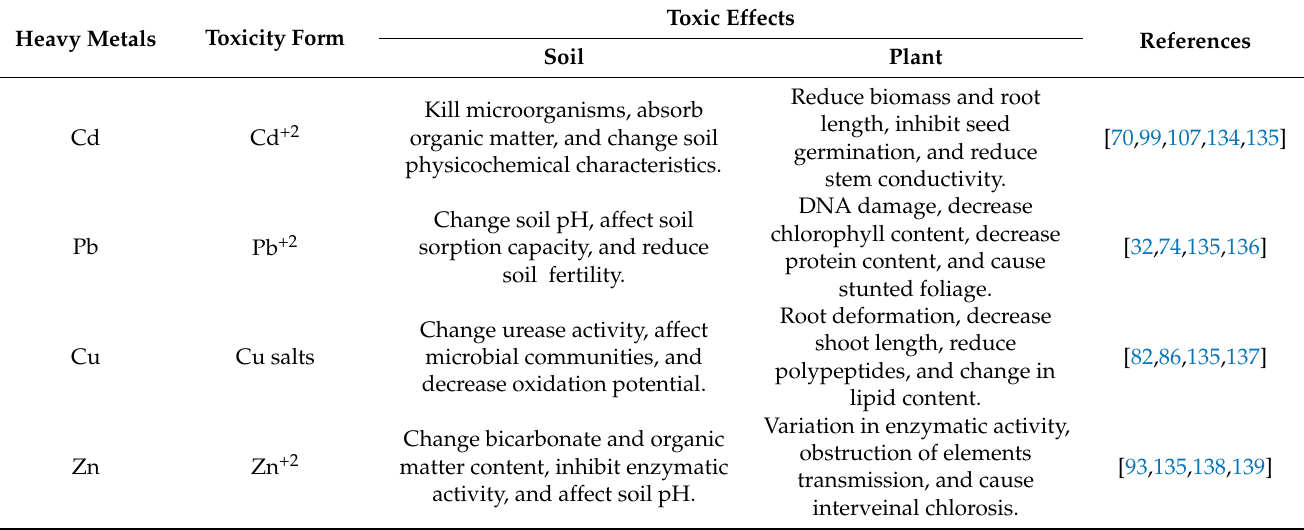
Table 5. Heavy metal toxicity forms and their toxic effects on soil and